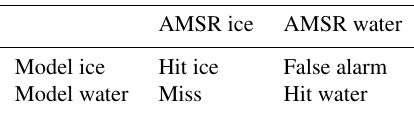
Table 3. Contingency table entries for sea ice verification of the PSY4V3 system compared to AMSR sea ice concentration obser-